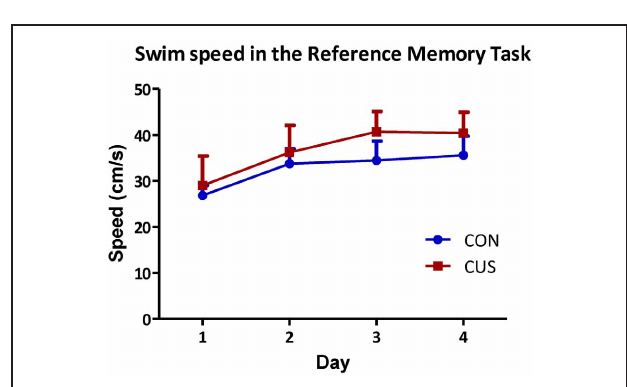
(CON, blue), short term stress (STS, green) and chronic unpredictable stress (CUS, red); (inset) representative recordings of fEPSPs pre- and post-HFS (scale bar: 1mV; 5ms) of a CON rat; (B) Normalized values of LTP averaged for the three groups of rats: CON, STS, and CUS; ∗ statistically different from controls, p < 0 . 05; error bars represent SD.